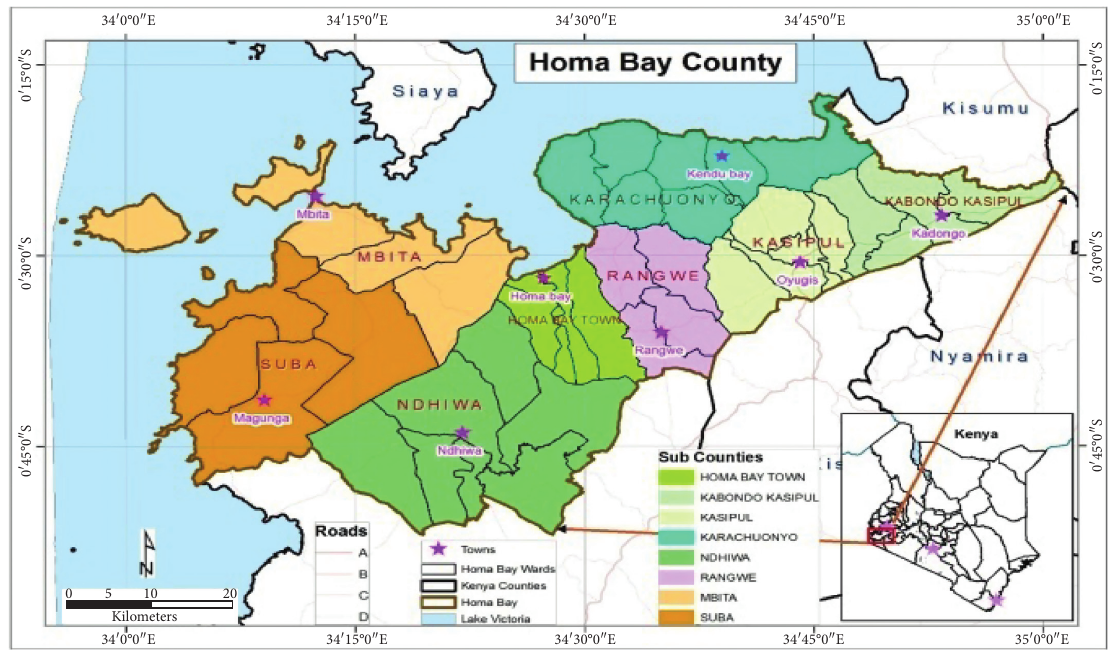
Figure 1: Subcounties in Homa Bay County (source: GoK